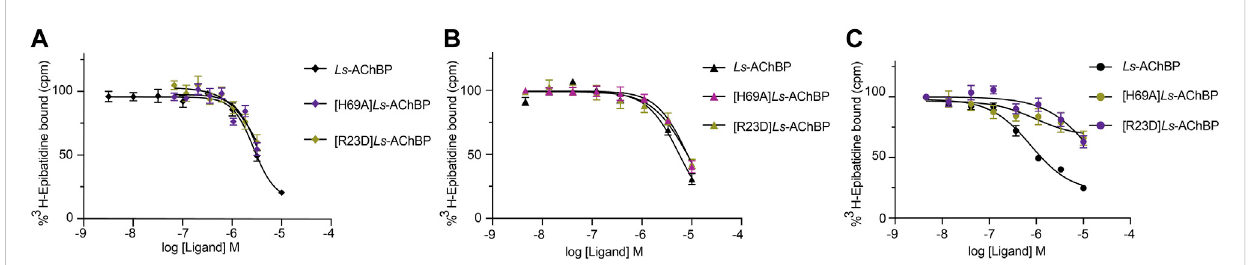
FIGURE 8 Concentration-response curves of VxXXB-C (19 – 50) (A) , VxXXB-NC (B) and VxXXB-CNC (C) at wild-type and mutant Ls -AChBP, [H69A] Ls -AChBP and [R23D] Ls -AChBP obtained via a competition radioligand binding